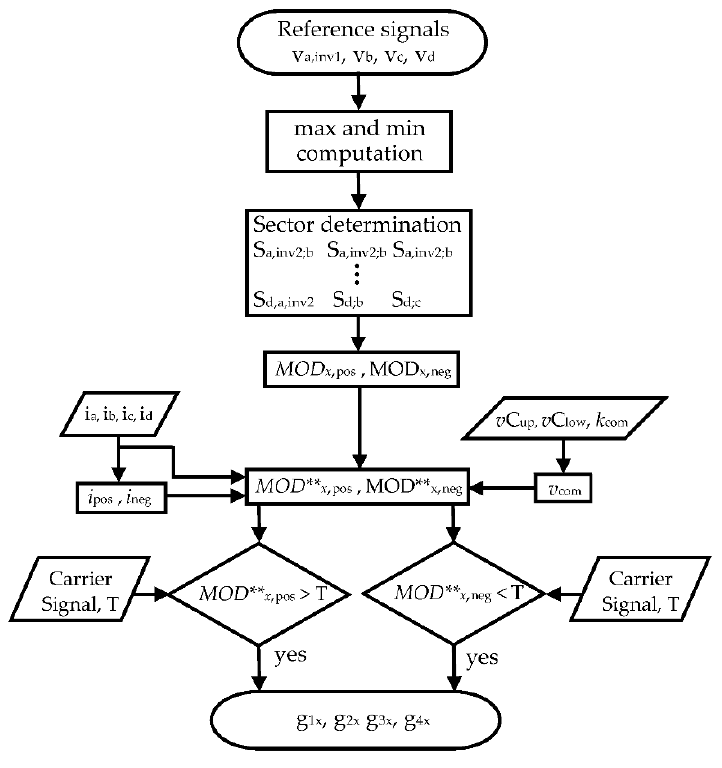
Figure 6. Flowchart of the modulating scheme.